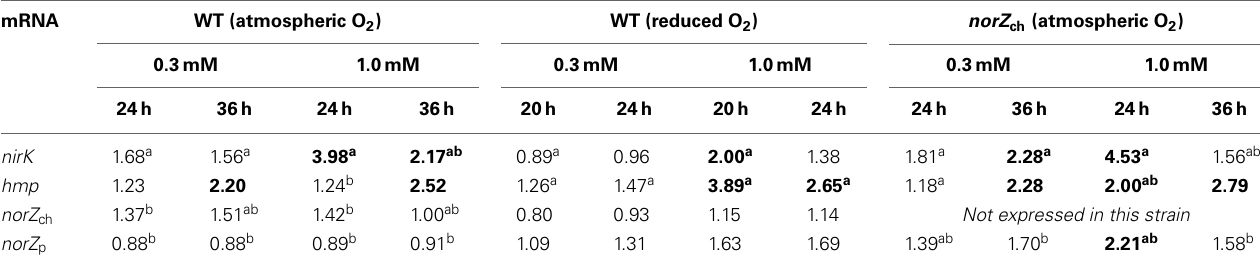
Table 5 | Effect of nitrite and O 2 on levels of specific transcripts of S. wittichii RW1 from mid-log and early stationary phase cultures. mRNA WT (atmospheric O 2 ) WT (reduced O 2 ) norZ ch (atmospheric O 2